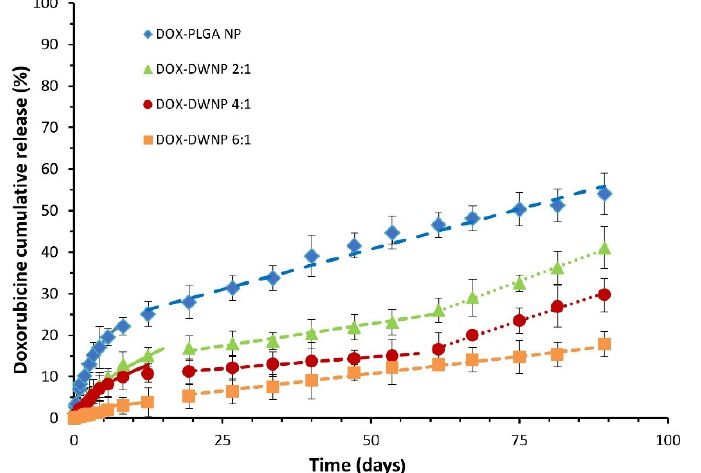
Figure 5. Cumulative DOX release profiles from PLGA NP and DWNPs made of PLLA and PLLG in the mass ratios of 2:1, 4:1 and 6:1, expressed as the percentage of DOX released. Solid lines were obtained by the Korsmeyer Peppas model (Equation (1)). Dashed lines obtained by zero order kinetic models.